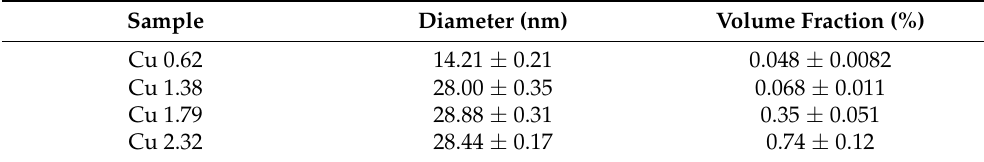
Figure 7. TEM morphologies and components by EDS of Cu precipitates. ( a ) Cu 0.62, ( b ) Cu 1.38, ( c ) Cu 1.79, ( d ) Cu 2.32. The black ellipse precipitates are Cu precipitation. Table 2. Diameter and volume fraction of Cu precipitates.